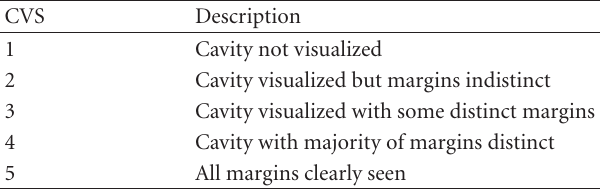
Table 1: Patient and imaging data. Table 2: Cavity visualization score